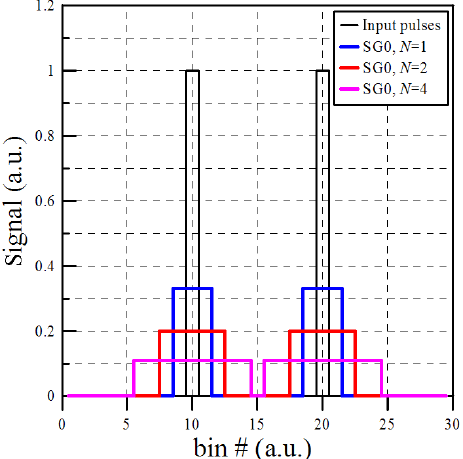
Figure 8. Two unitary pulses (thickness = (cid:49)R raw = 1, distance be- tween pulses = 9 bins, black line) after the application of SG0 with N = 1 (length M = 2 N + 1 = 3, blue line) and N = 2 (length M = 2 N + 1 = 5, red line), become 3 (cid:49)R raw - and 5 (cid:49)R raw -wide pulses respectively. For N >4 the two pulses cannot be distin- | Ray = 9 bins guished: (cid:49)R SG0 eff